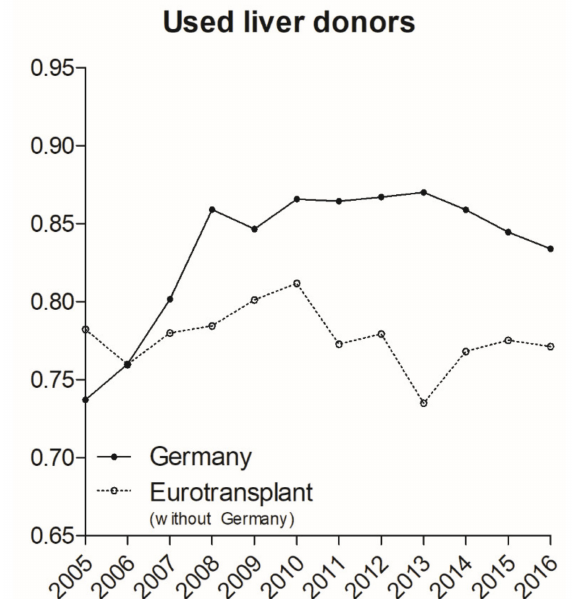
Figure 6. Used liver donors compared to all reported liver donors. While both areas showed a similar utilization of around 75% of all reported liver donors in the years before MELD implementation, the ratio increased in Germany after 2006 to around 85%. Source: Annual Reports of Eurotransplant. MELD, Model for End-Stage Liver